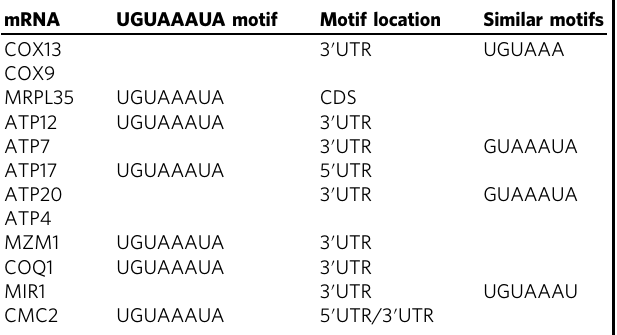
Table 1 Motif analysis on Puf3